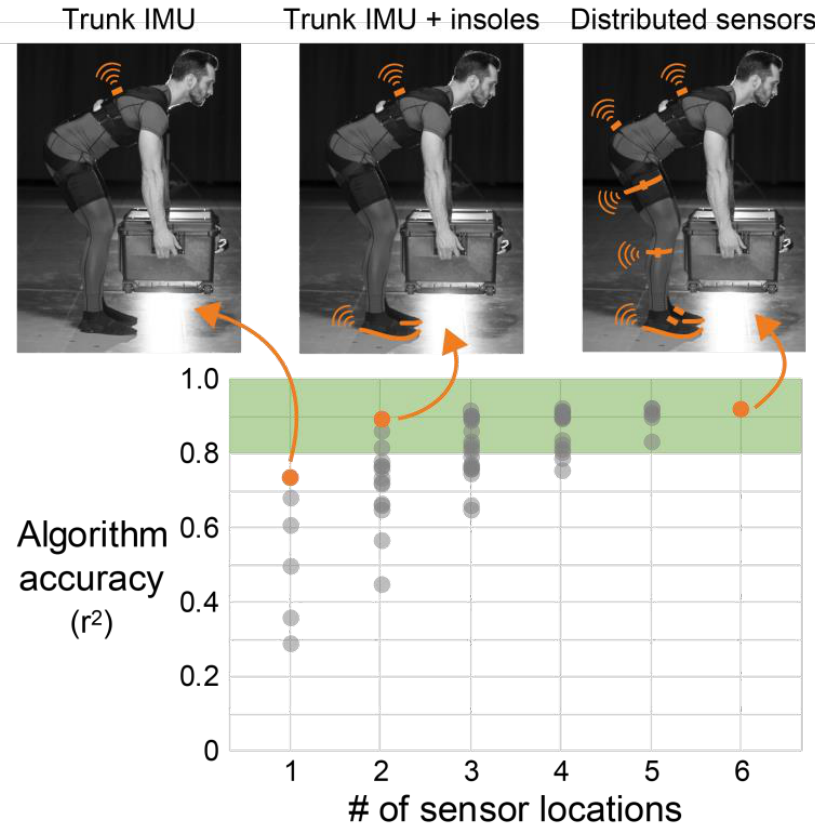
using two sensor locations to r 2 = 0.92 using all six sensor locations, the maximum number of distributed sensor locations in this study).